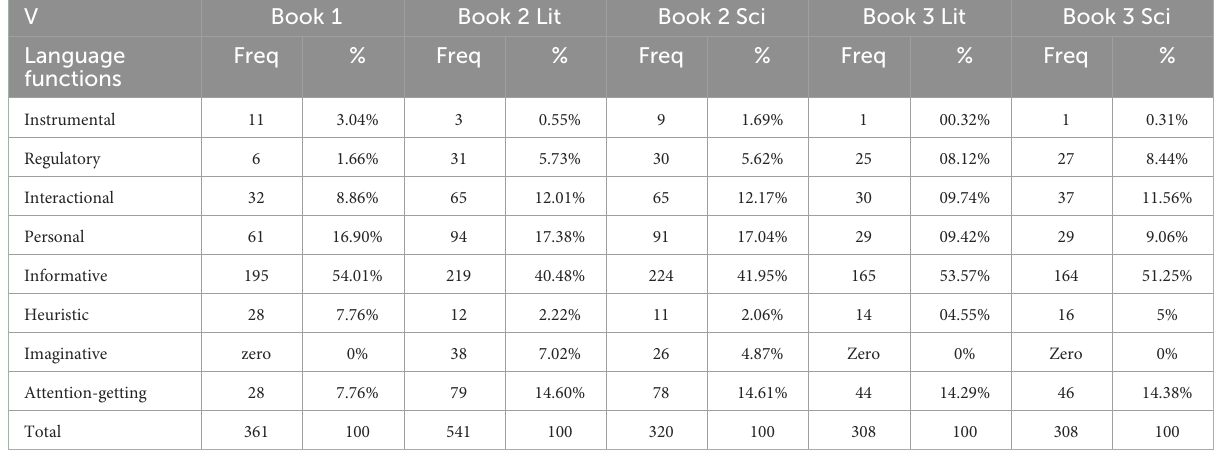
TABLE 3 Frequency of language functions in 21st Century English for Libya secondary 1, 2, and 3 course books and